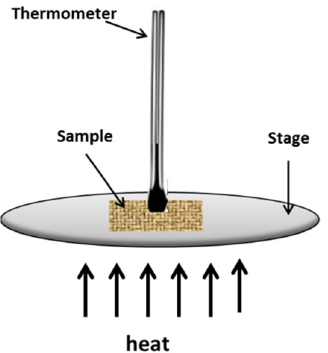
Figure 2. Thermal conductivity test arrangement.